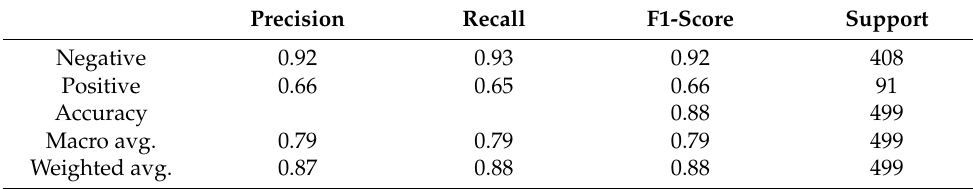
Table 5. BERT topic classifier performance: NPIs.